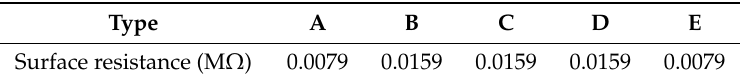
Figure 10. The equivalent circuit of a bushing.